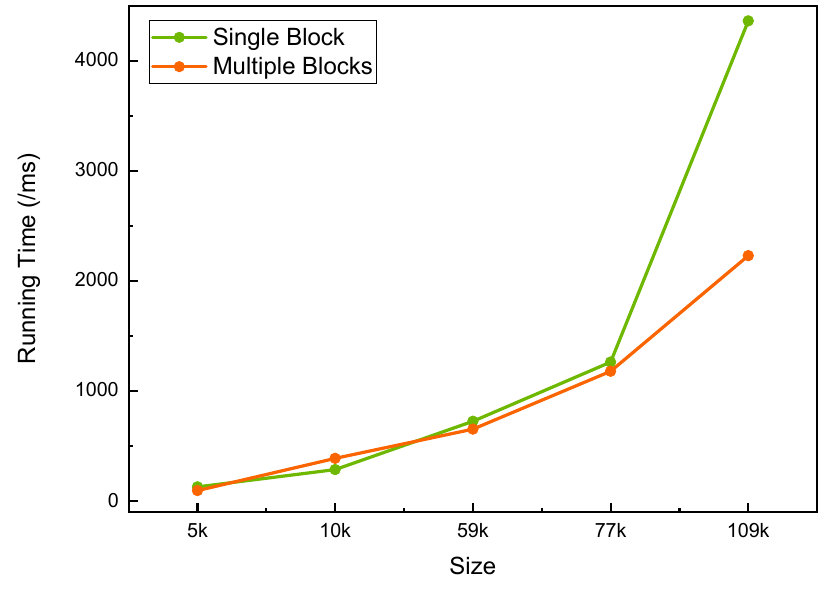
Figure 12. Running time when using single block and multiple